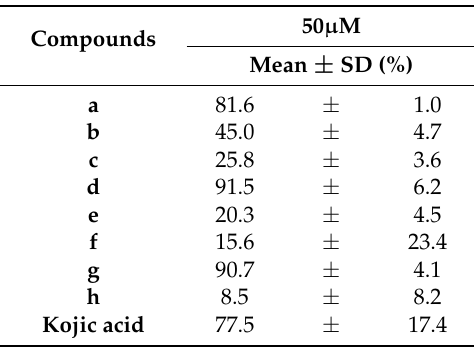
Table 1. Effects of MHY1498 on mushroom tyrosinase activity. L -tyrosine was used as the substrate for mushroom tyrosinase and was added to the mixture as a test material. The inhibitory activity of mushroom tyrosinase was measured after treatment with the synthesized compounds and kojic acid (50 µ M). The values shown are the mean ± SD of three determinations.